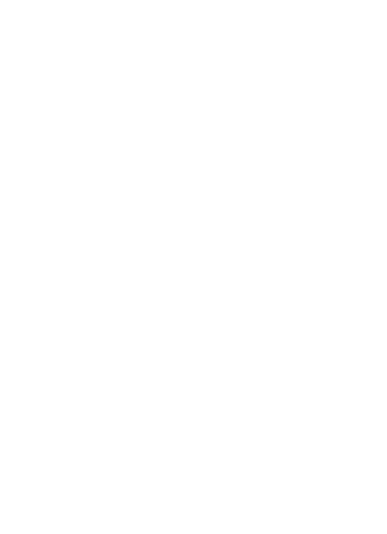
Figure 10. XPS of ( a ) Fe 3 O 4 @SiO 2 -PMA-Cu, ( b ) Fe 3 O 4 and ( c ) Fe 3 O 4 @SiO 2